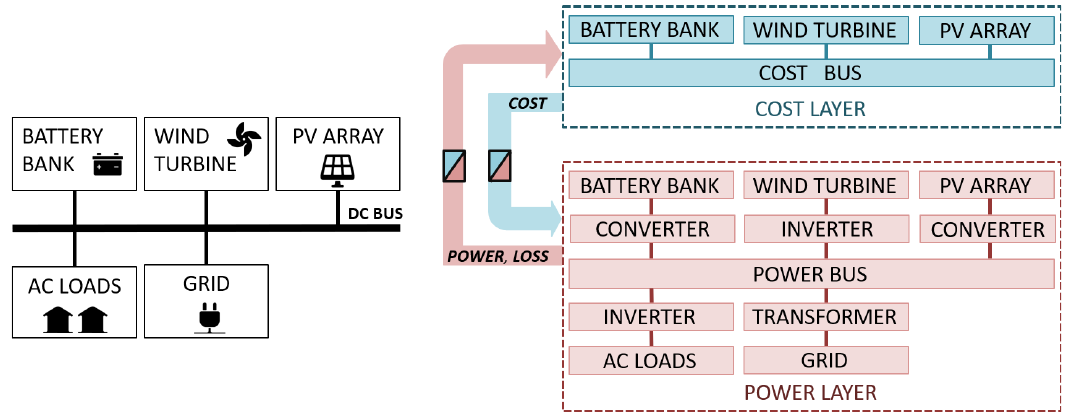
Figure 5. Structure of the electrical energy system (EES) case study 1 ( left ) and result of the application of the proposed approach ( right